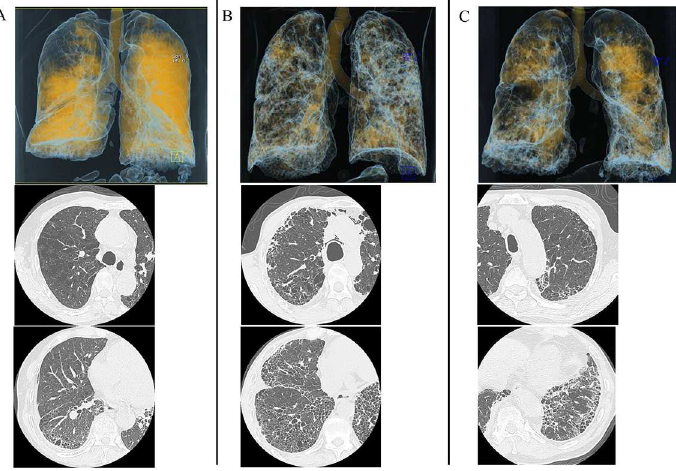
Fig 3. Image analysis of ventilation defect in CPFE. (A) CPFE of upper-predominant defect type shows xenonenhancement defect in emphysematous lesionsaffecting predominantly in both upper lobes, on the other hand relatively preserved in both lower lobes with sporadic fibrosis.(B) CPFE of diffuse defect type shows uneven diffuse defects of xenonenhancement in both lungs, without large enhancement defects like COPD.(C) CPFE of multifocaldefect type shows multifocaldefects of xenonenhancement in both lungs, without large enhancement defects like